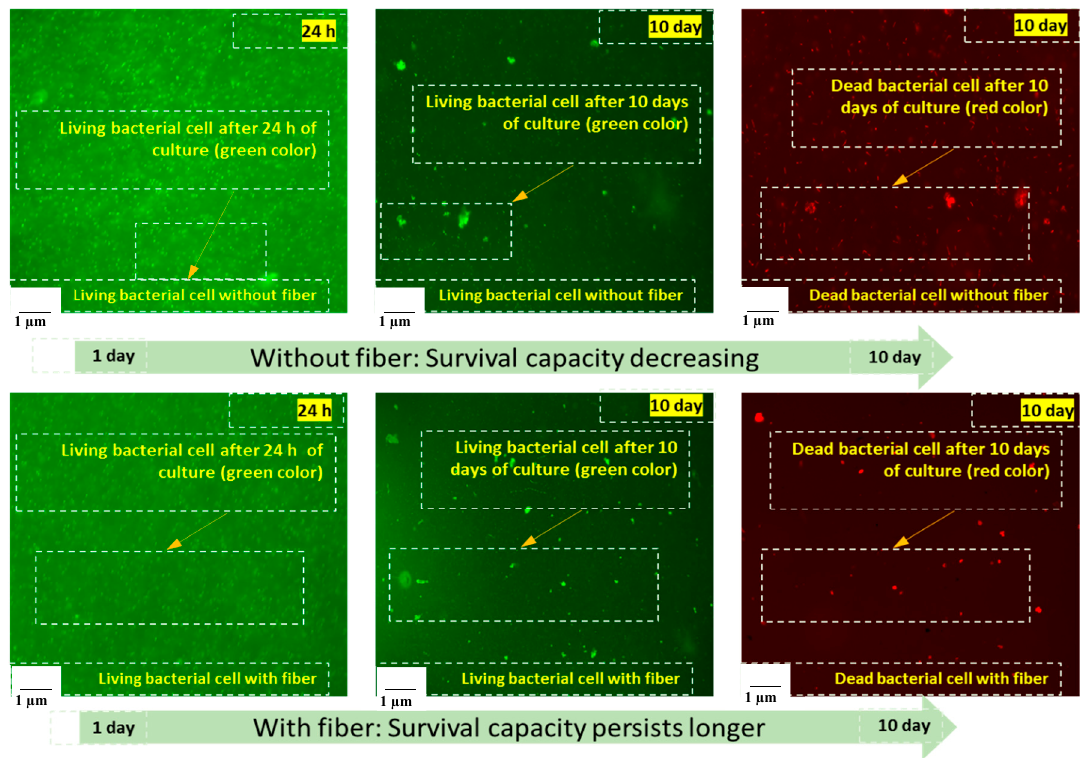
Figure 9. Fluorescence microscopic images living and dead bacterial cell (with and without fiber).